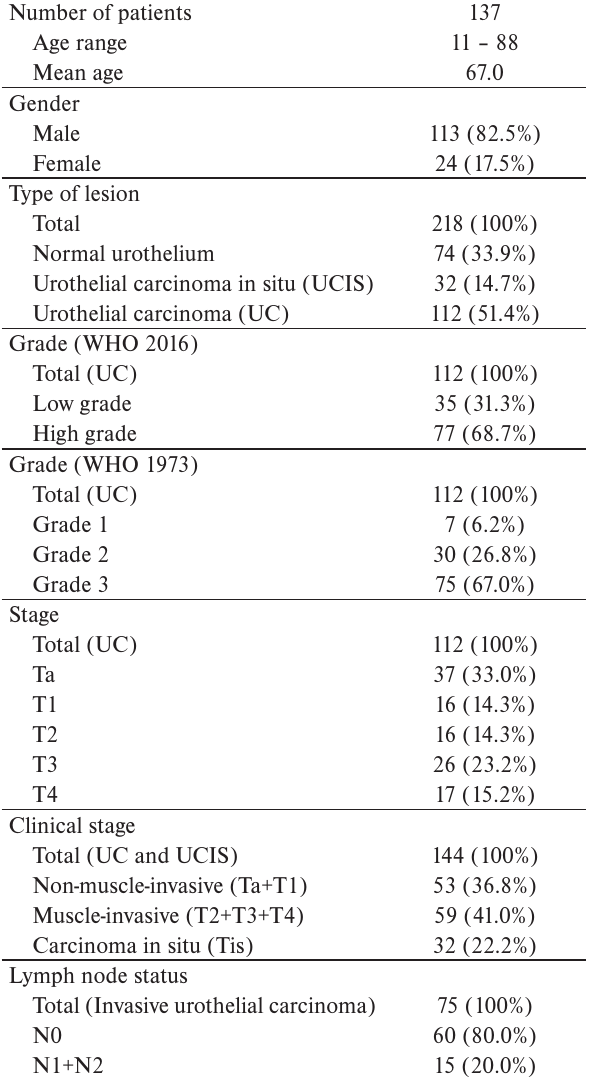
Table 1. Patient and specimens